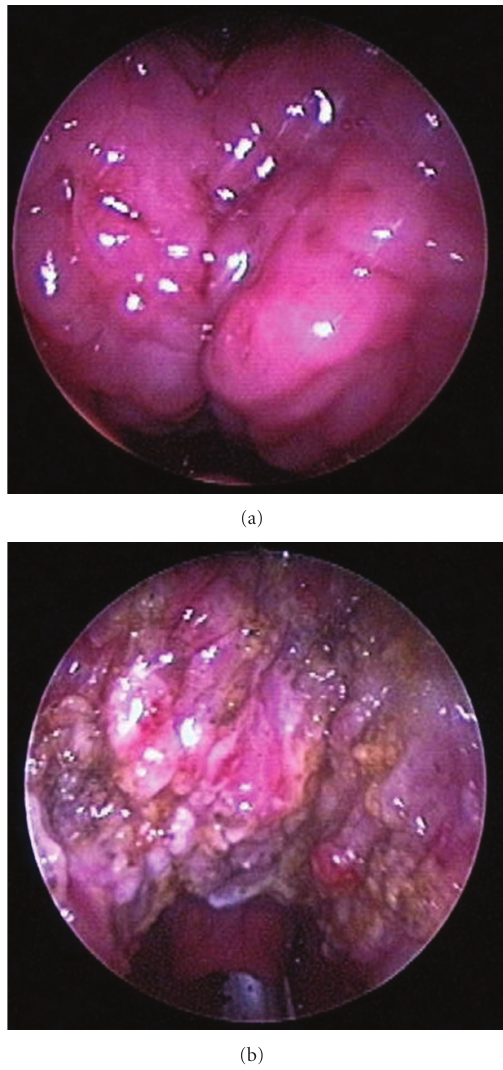
Figure 6: (a) Lingual tonsils prior to endoscopic-assisted coblation lingual tonsillectomy. (b) After lingual tonsillectomy, the epiglottis can now be